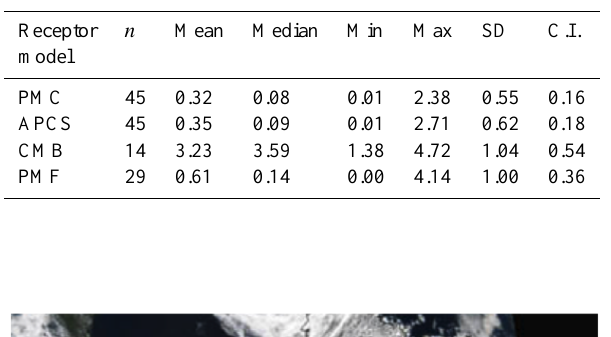
Table 7. Boreal wildfire woodsmoke source apportionment (µgm − 3 ) descriptive statistics by receptor model.